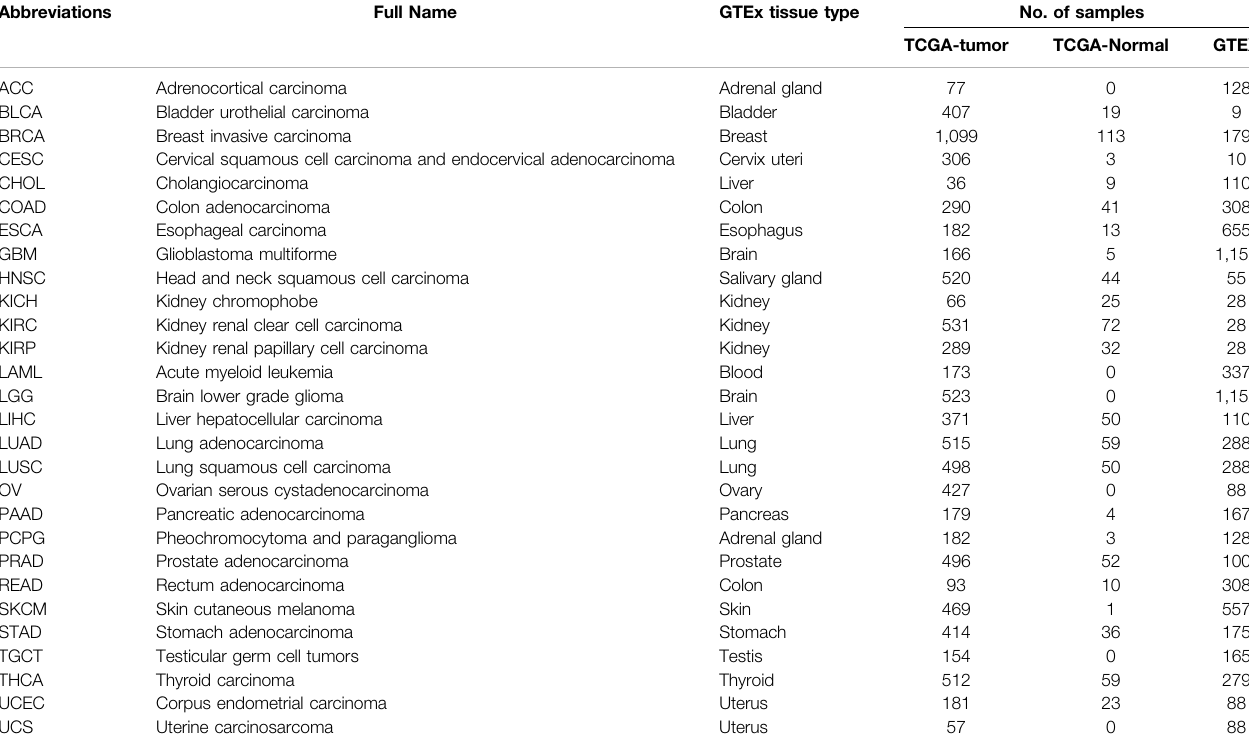
TABLE 1 | 28 cancer types from TCGA and corresponding normal tissue samples from GTEx used for gene expression pro fi